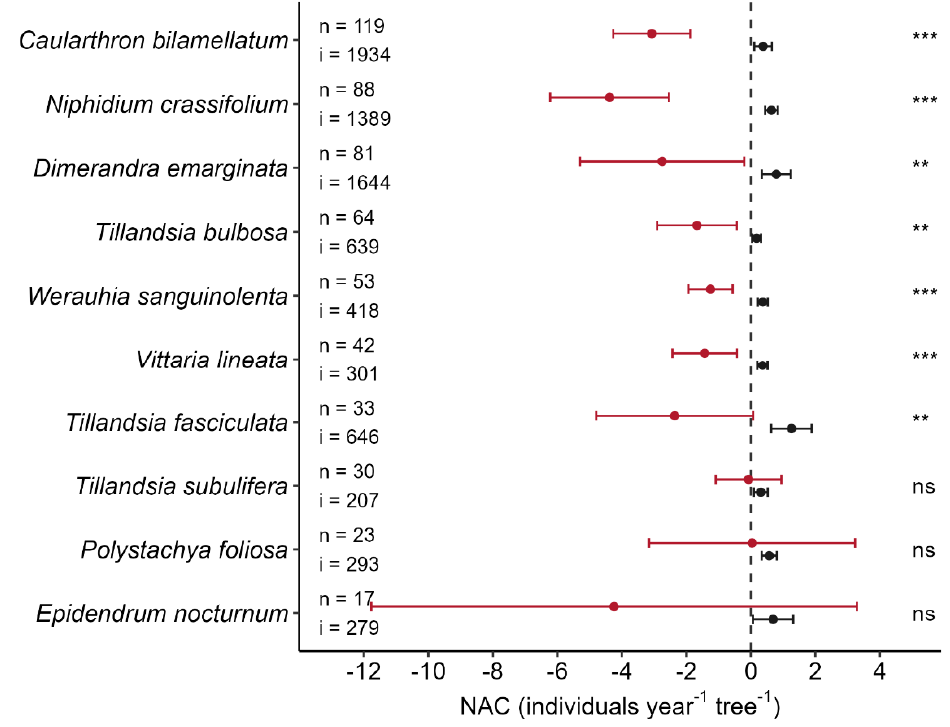
Figure 2. Net abundance change (NAC, individuals year − 1 tree − 1 ) of the ten most abundant epiphyte species for the reference period (black) and for the 12 months with the El Niño event (red). Dots give the mean NAC and ranges the 95% confidence interval of the mean NAC for each period and species. The number of populations per species is given as ‘ n ’ (= number of occupied trees) and the total number of individuals during the El Niño period as ‘i’. Totals refer to the total number of observed occupied trees/individuals in 2016, e.g., Tillandsia subulifera occurred on 29 trees in 2015, but on only 25 trees in 2016, one of which was not occupied in 2015, thus the total is n = 30. For each species, one-sided paired t -tests were conducted for the differences in means between the reference and the El Niño period. Significance levels are given as asterisks ( p < 0.001: ***; p < 0.01: **; p ≥ 0.05: not significant, ns).